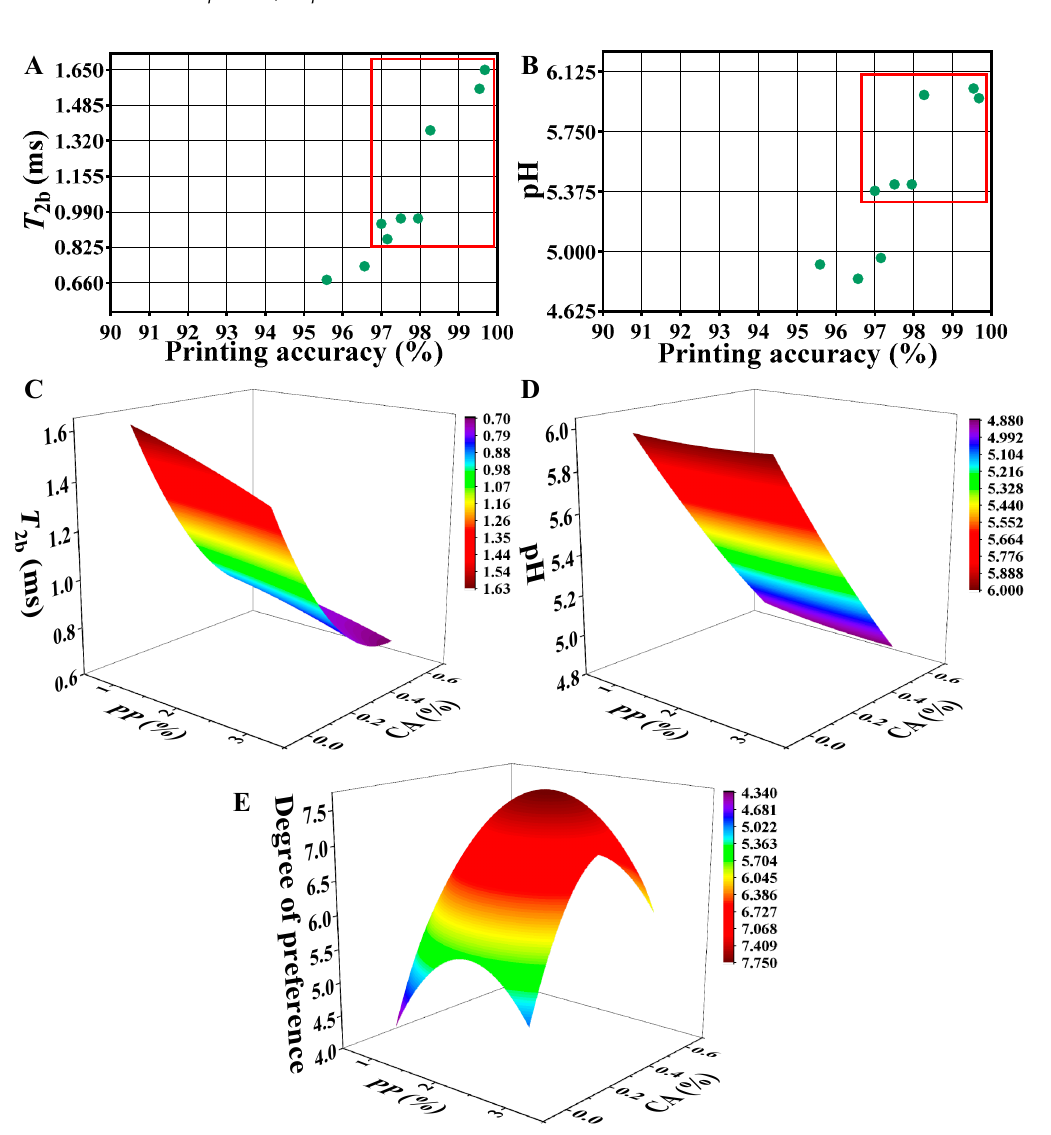
Figure 10. Correlation analysis data charts: ( A , B ) are the effects of T 2b and pH on the accuracy of 3D printing; ( C – E ) are the nonlinear surface fitting of T 2b , pH, and degree of preference to PP and CA, respectively. ( A , B ) use red box coils to print points with an accuracy greater than 97%. The pH, T 2b , and degree of preference (DP) values were fi tt ed to a nonlinear surface with PP concentration ( x ) and CA addition ( y ) to obtain Equations (3)–(5).